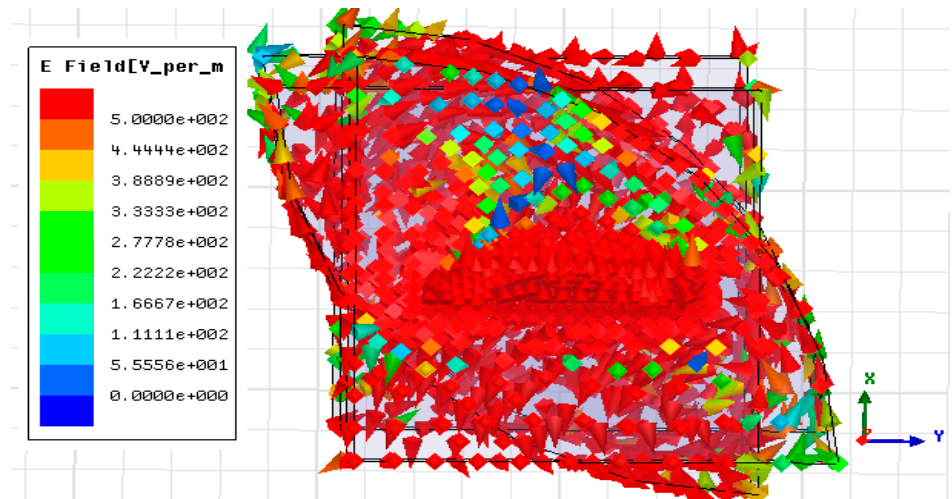
Figure 11. Electric- field’s pattern inside multi-stacked DRA.